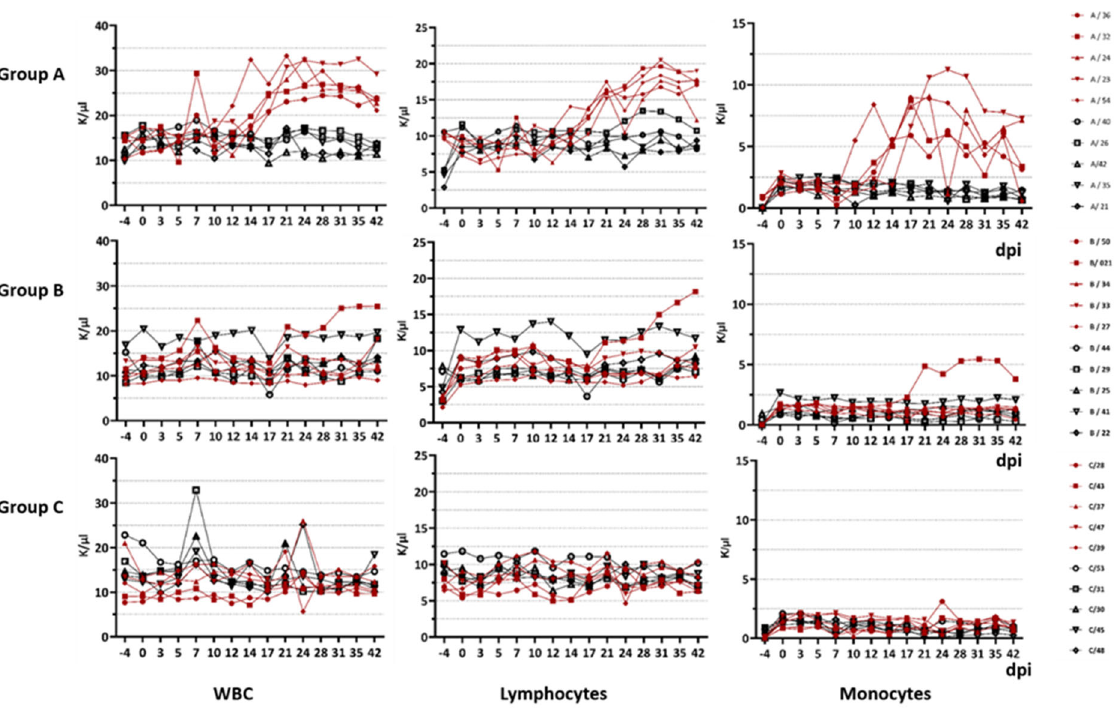
Figure 2. Total WBC count, total lymphocyte count and total monocyte count of the EDTA blood. Comparing the total WBC count of goats infected with the atypical BTV strains (me ‐ dian of 19.7) to the classical BTV ‐ 8 strain (median 9.44) during all 15 blood sampling times ( α = 0.0033), the WBC count was significantly higher for the atypical BTV strains ( p < 0.0001). The differences between the total WBC count of the 14 blood sampling time points compared to the 0 dpi of the respective animals ( α = 0.0036) were significantly higher for the atypical BTV strains ( p = 0.0035) compared to the classical BTV group. Comparing the total lymphocyte count of goats infected with the atypical BTV strains (median of 10.14) to the classical BTV strains (median 6.84) during all 15 blood sampling times ( α = 0.0033), the lymphocyte count was significantly higher for the atypical BTV strains ( p < 0.0001). However, no significant differences ( α = 0.0036) between the atypical BTV and the classical BTV group were seen when the 14 lymphocyte blood sampling val ‐ ues were compared to the 0 dpi value of the respective animals ( p = 0.29).